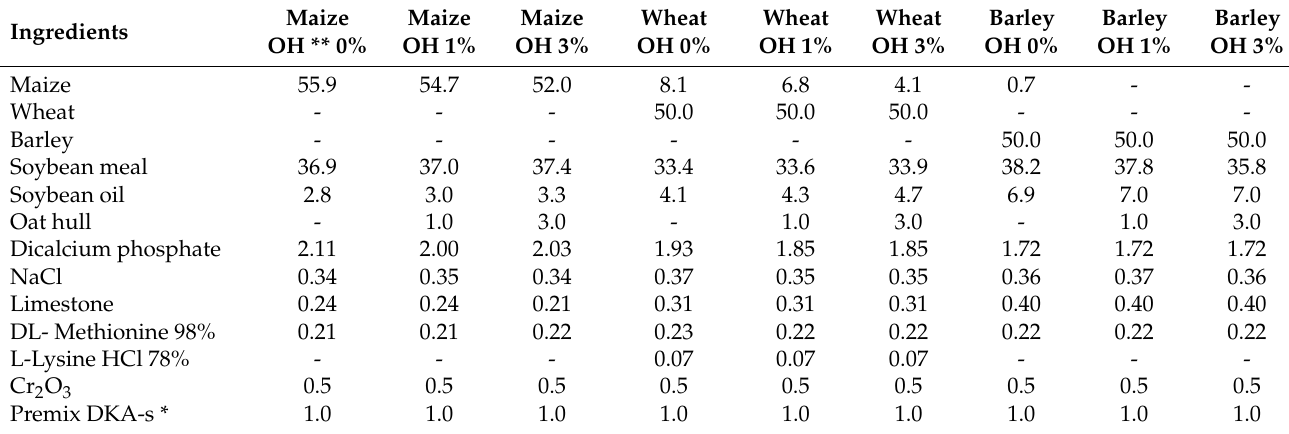
Table 1. Ingredient composition of diets